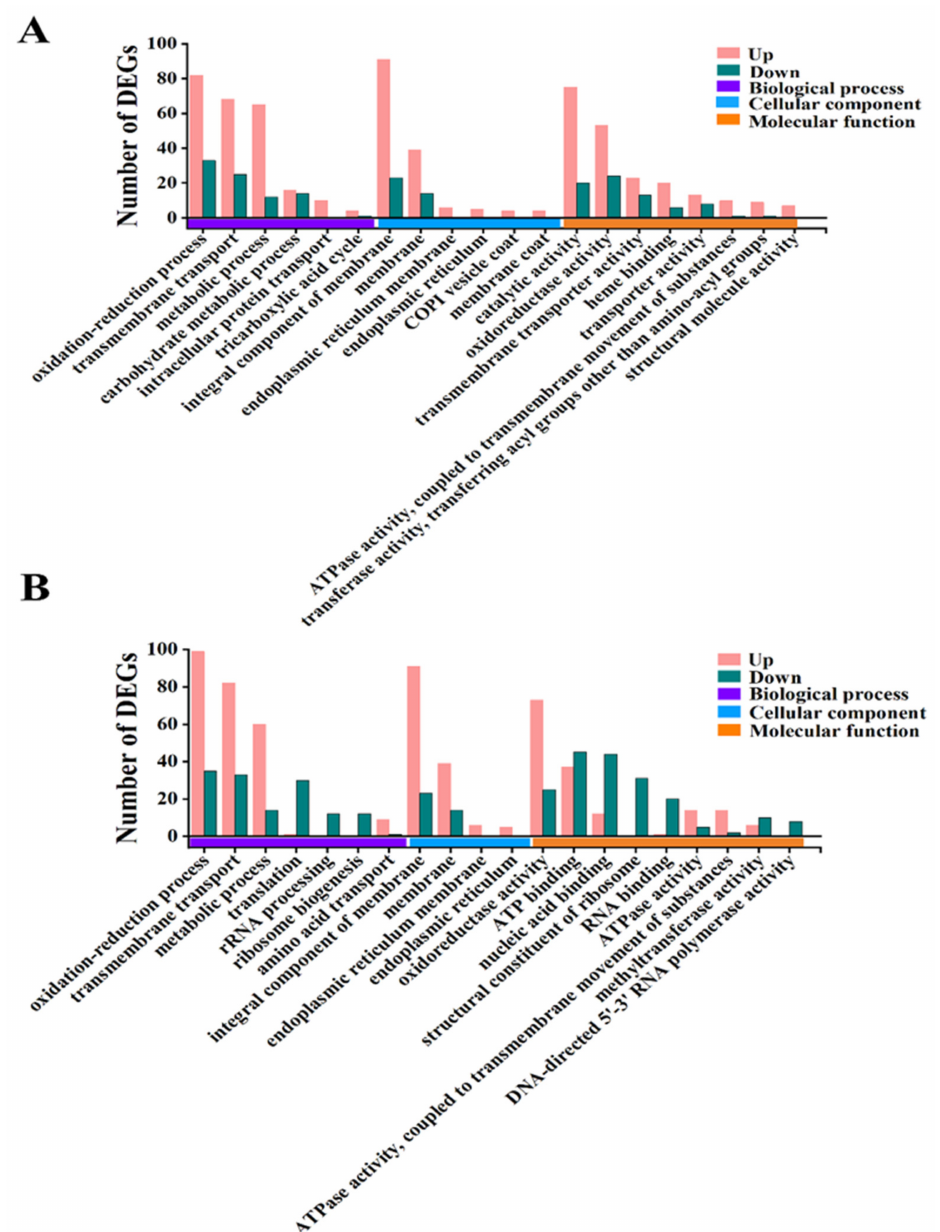
Figure 6. GO functional analysis of differential genes in F. oxysporum treated with 25 ( A ) and 50 µ g/mL ( B ) iturin